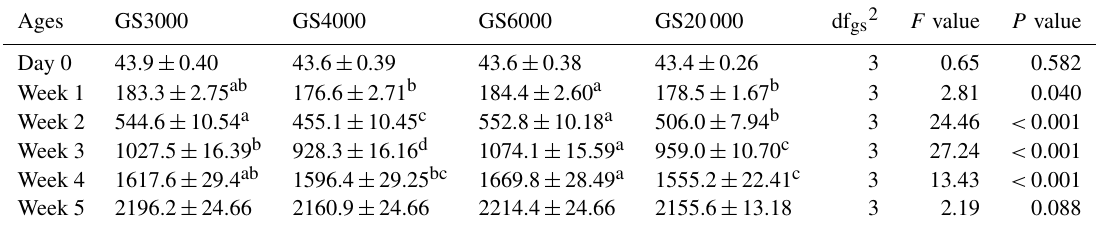
Table 3. Least square mean and standard error (SE) of weekly body weight changes (grams per week) in broilers reared in varying group sizes 1